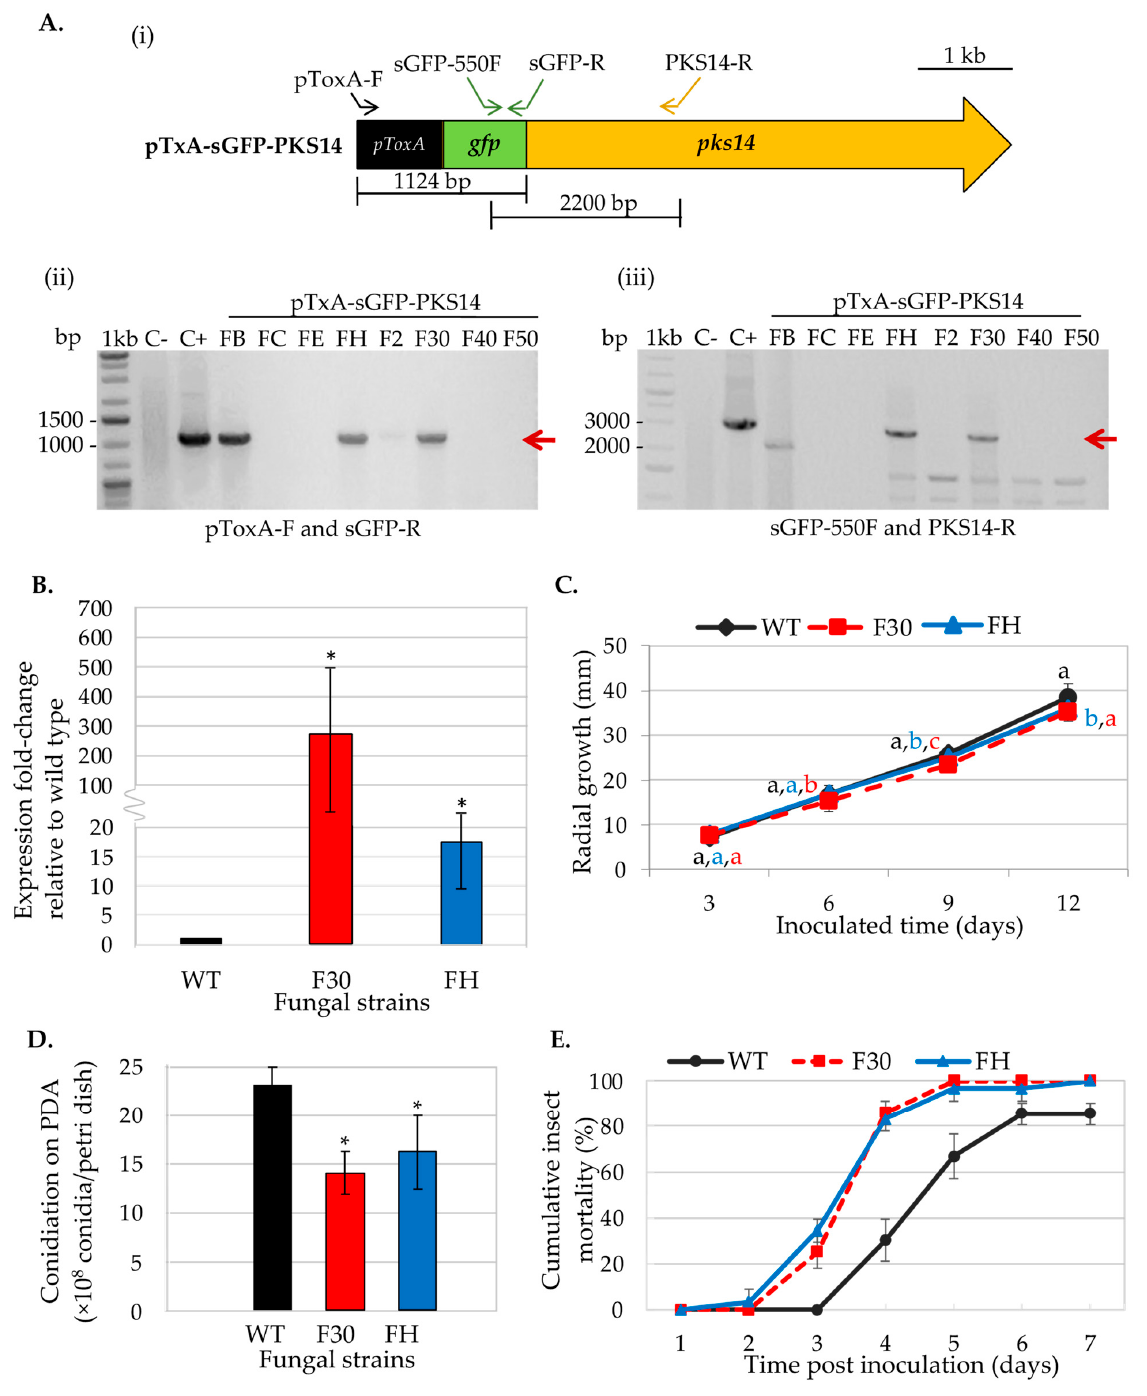
Figure 1. Phenotype characterization of OE pks14 strains. ( A ) Ectopic integration of the pks14- overexpression cassette was verified by PCR with specific primers ( i ). OE pks14 strains FH and F30 showed the expected bands at 1124 bp (red arrow) using primers pToxA-F and sGFP-R, specific for the ToxA promoter and sGFP , respectively ( ii ), and 2200 bp (red arrow) using primers sGFP-550F and PKS14-R, specific for the sGFP and pks14 , respectively ( iii ). B. bassiana BCC2660 genomic DNA and the vector pTxA-sGFP-PKS14 were used as negative (C-) and positive (C+) controls, respec- tively. ( B ) Gene expression level, ( C ) radial growth, ( D ) conidiation, and ( E ) insect mortality were impacted by OE pks14 strains FH and F30. The letters indicate a significant difference (ANOVA, p < 0.05). Asterisks indicate statistical significance ( t -test, p < 0.05).